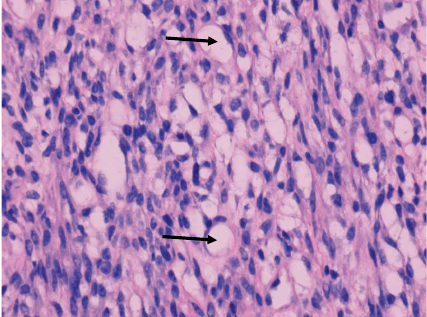
Figure 6: (400x, H&E) Round to oval clear cells with signet ring appearance admixed with spindled cells.